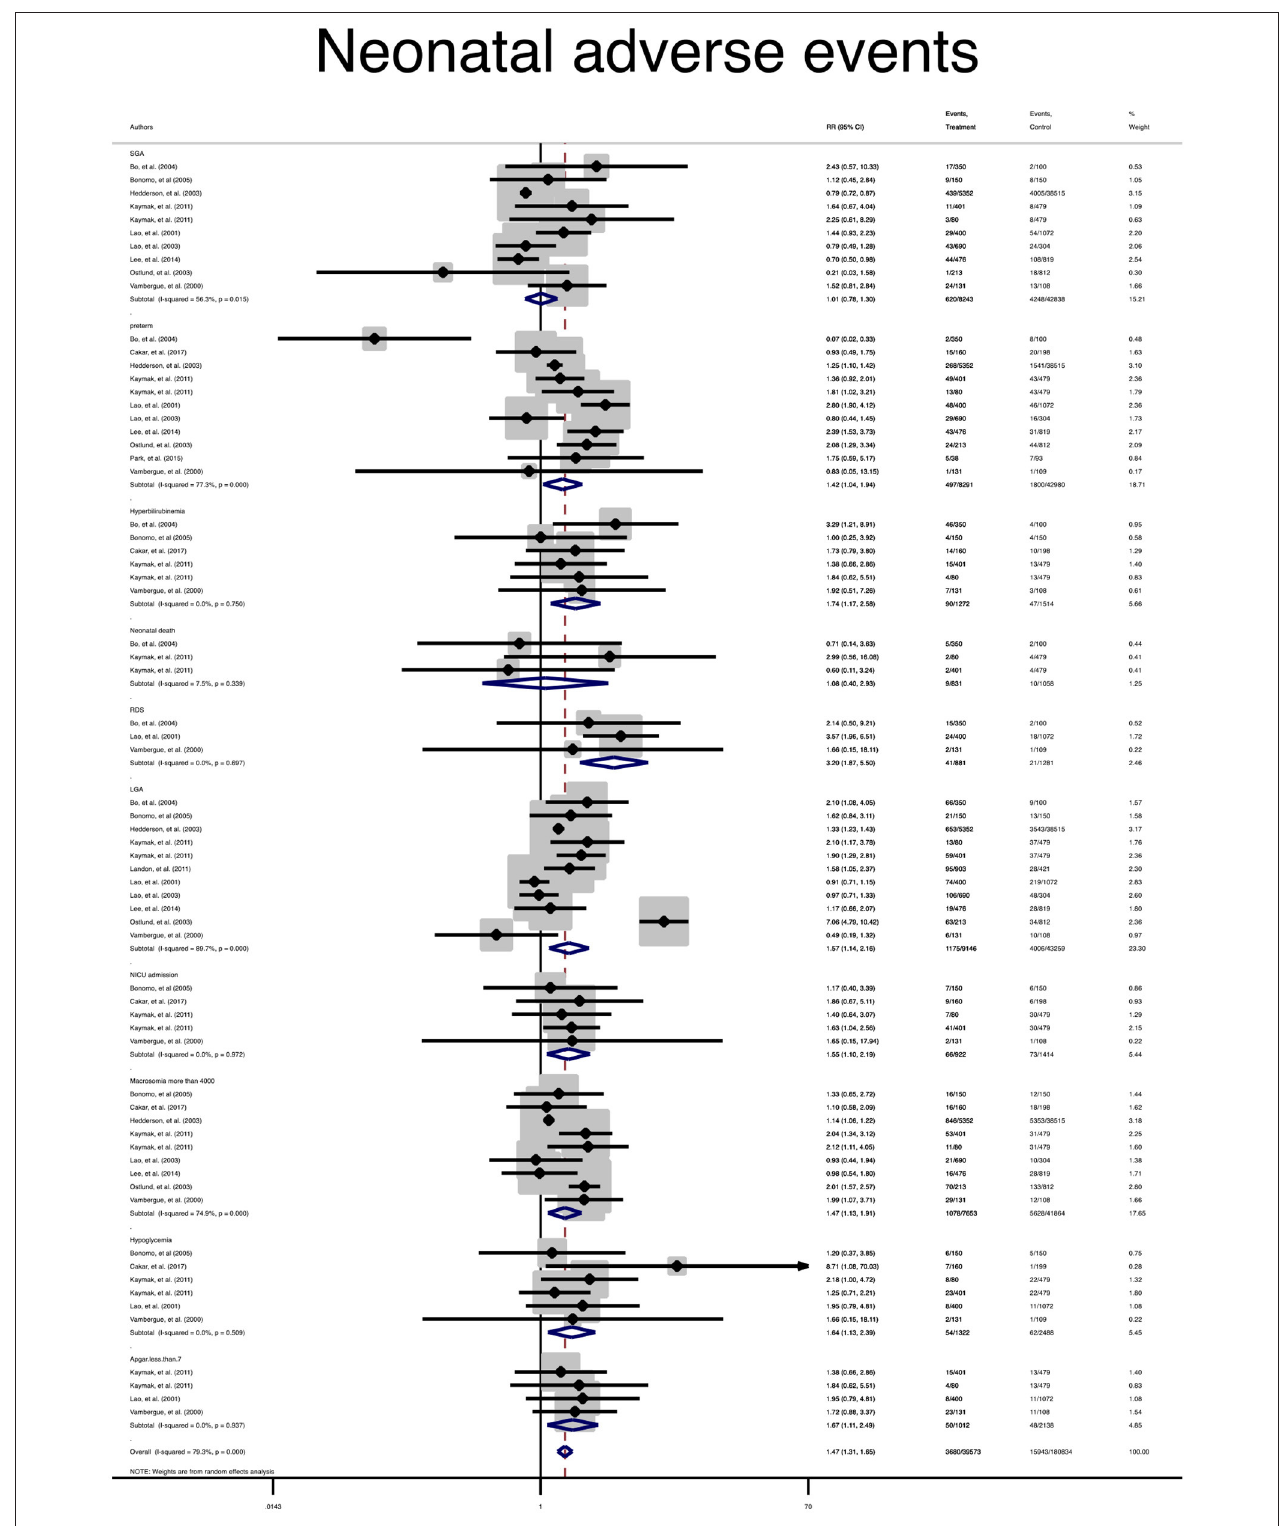
FIGURE 7 | Forest plot of pooled relative risk of adverse neonatal events with the exclusion of studies that fulfilled the IADPSG (HAPO) criteria.